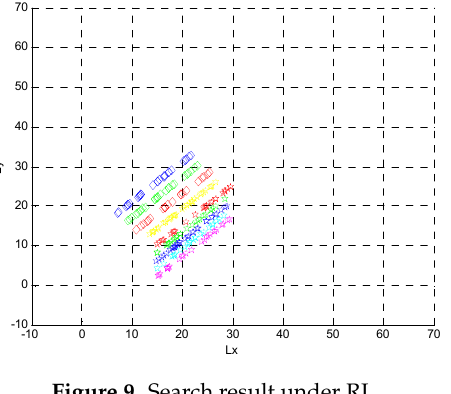
Figure 9. Search result under RL.